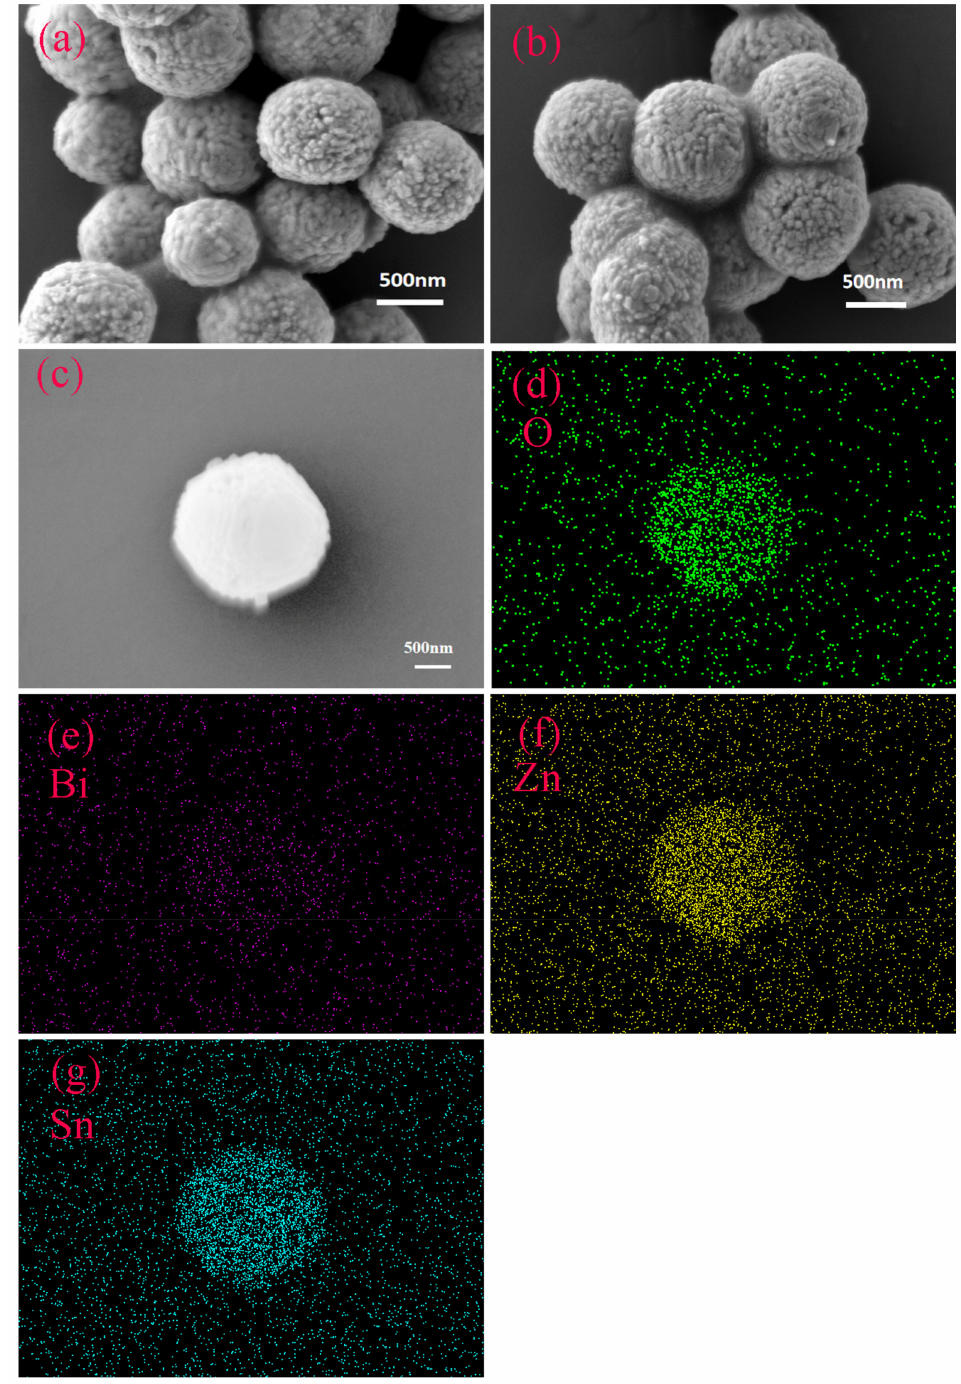
Figure 3. ( a ) SEM image of ZnSnO 3 , ( b ) Bi-ZnSnO 3 , and ( c – g ) elemental distribution of Bi-ZnSnO 3